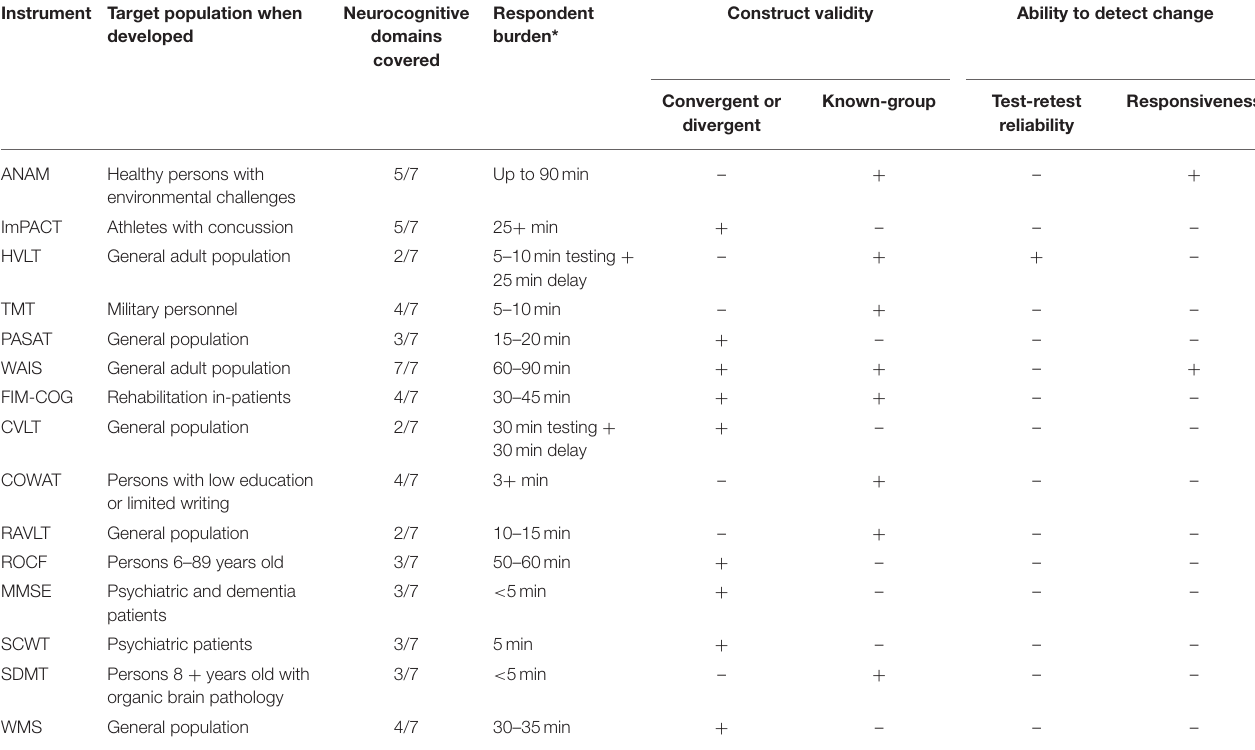
TABLE 4 | Summary of measurement properties of evaluative instruments of cognitive functioning in TBI samples. Instrument Target population when